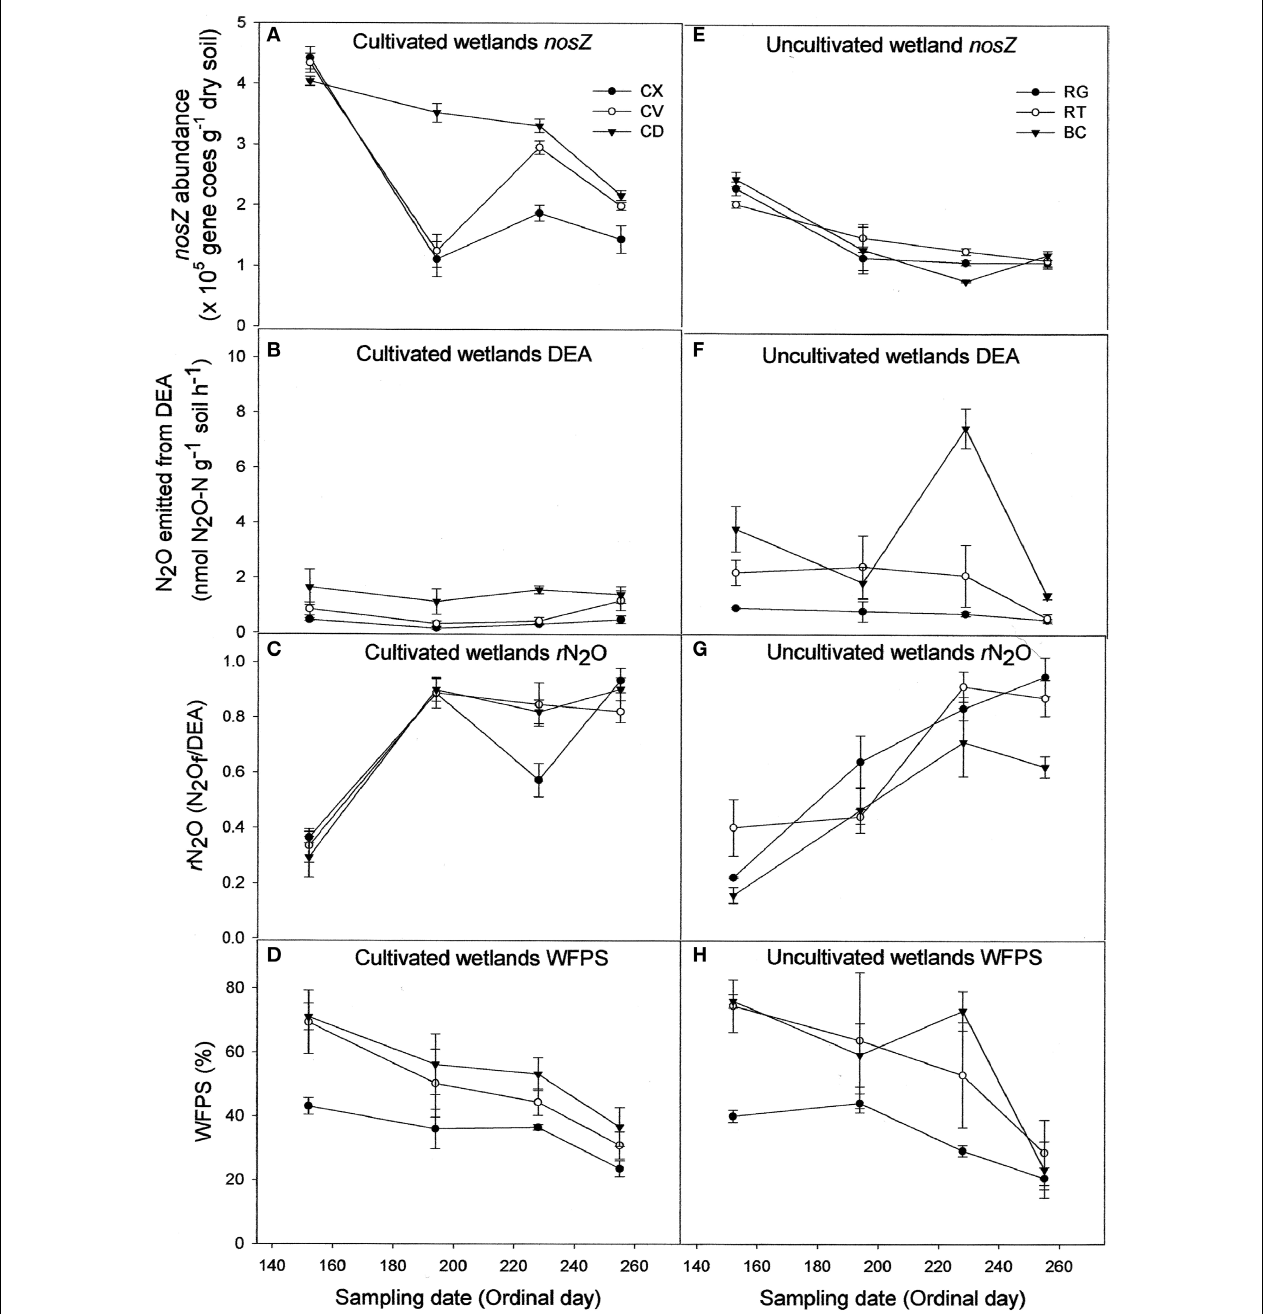
elements, basin center (BC), surrounded by a non-level fringe area covered with grasses (RG) and an outer region consisting of trees or shrubs (RT). Based on profile curvature, BC elements are analogous to CD elements, and RT elements are analogous to CV elements. Riparian grass (RG) elements and CX elements represent the driest landforms within the respective wetland type. Reported values are means ( n = 3) with SE